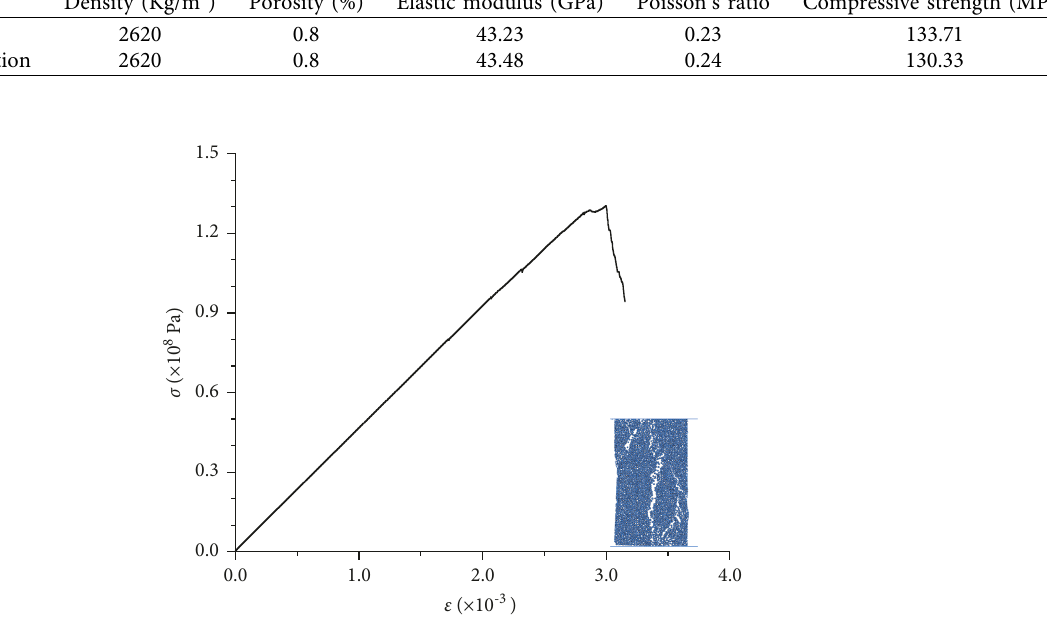
Figure 6: Test results of rock’s unconfined compressive strength.